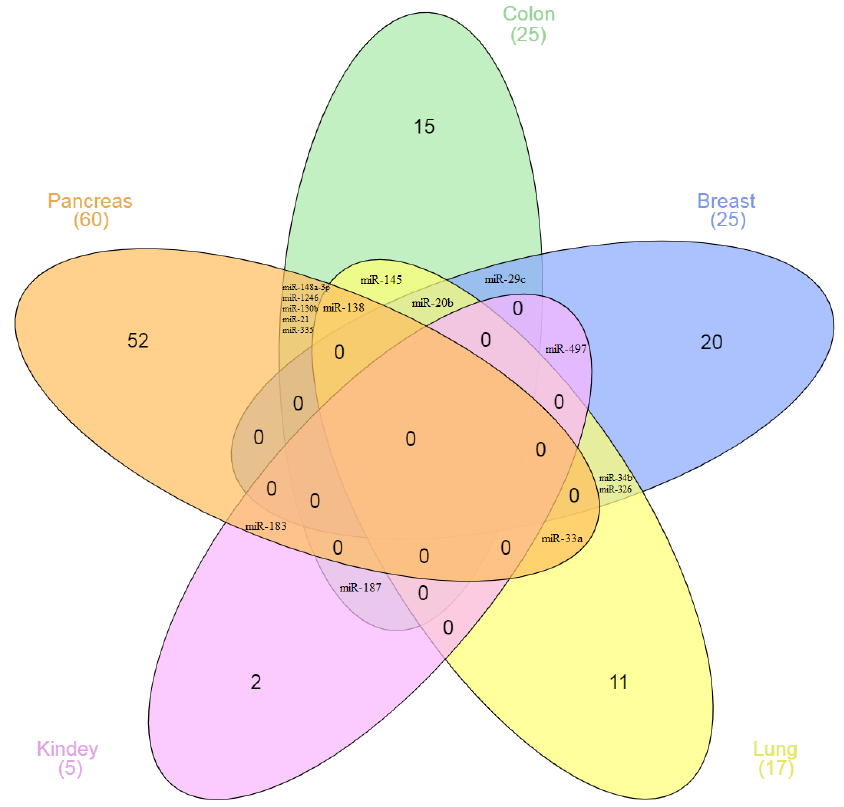
Figure 2. The Venn diagram of the number of miRNAs interacting with IC genes in various types of cancer.